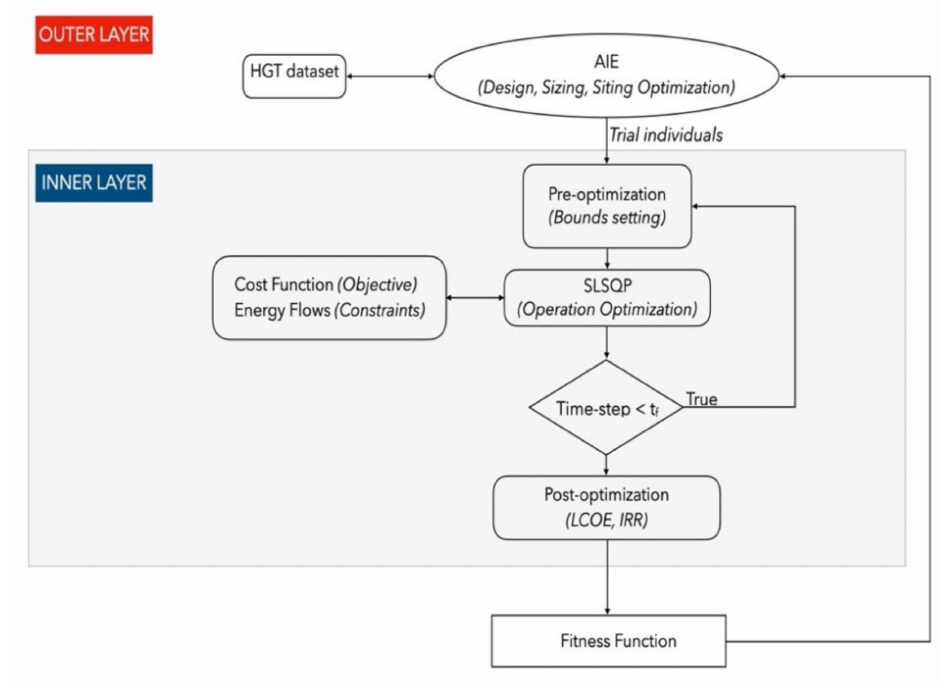
Figure 1. Framework of the two-layer optimization